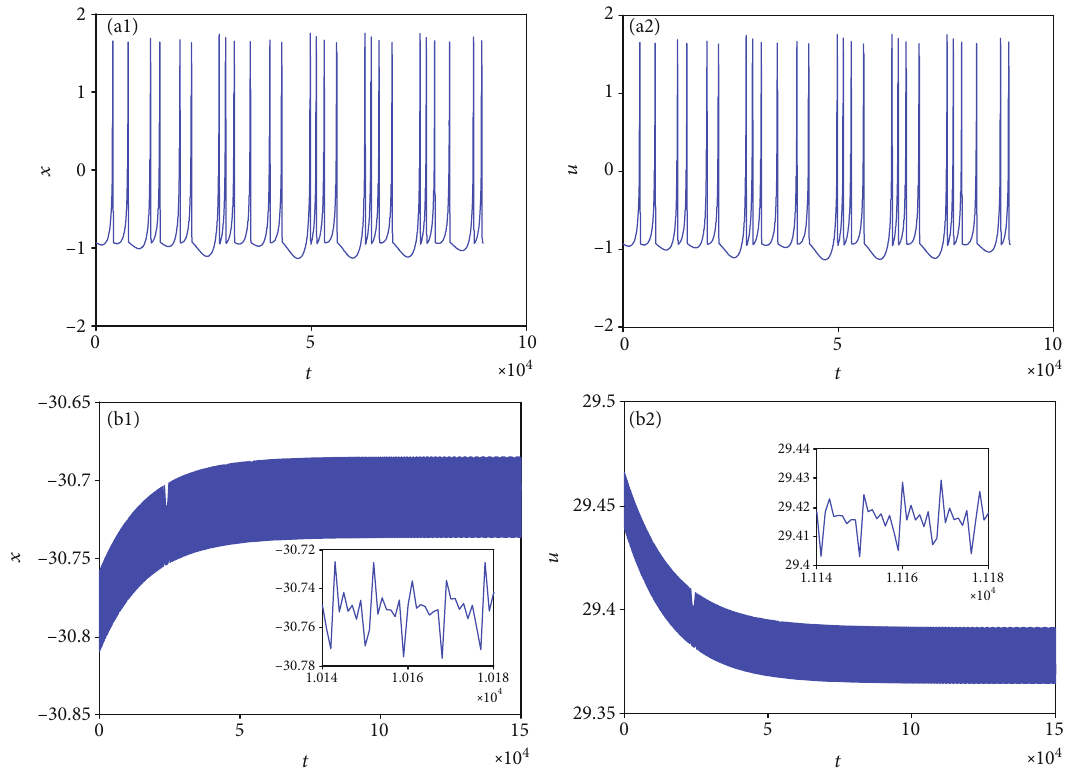
Figure 15: Multiple fi ring patterns of membrane potentials in model (2) when k = 0 : 5 and I ð 0, 0, 0, 0, 0, 0, 0 Þ . (b1 and b2) Time series for initial value ð − 2, 0, 0, 2, 0, 0, 0 Þ .